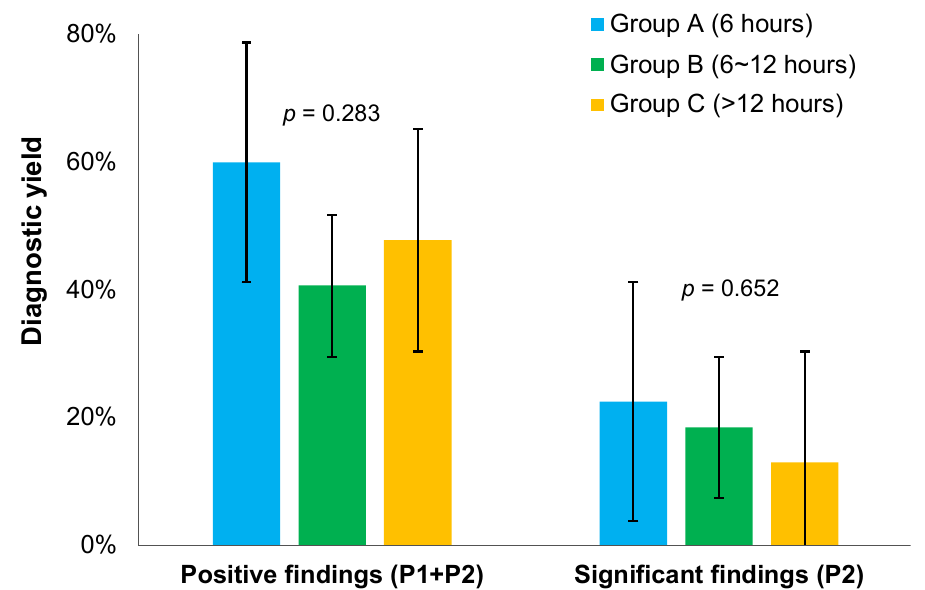
Figure 2. Diagnostic yields of positive and significant findings according to the timing of bowel preparation. (Error bar; 95% confidence interval).